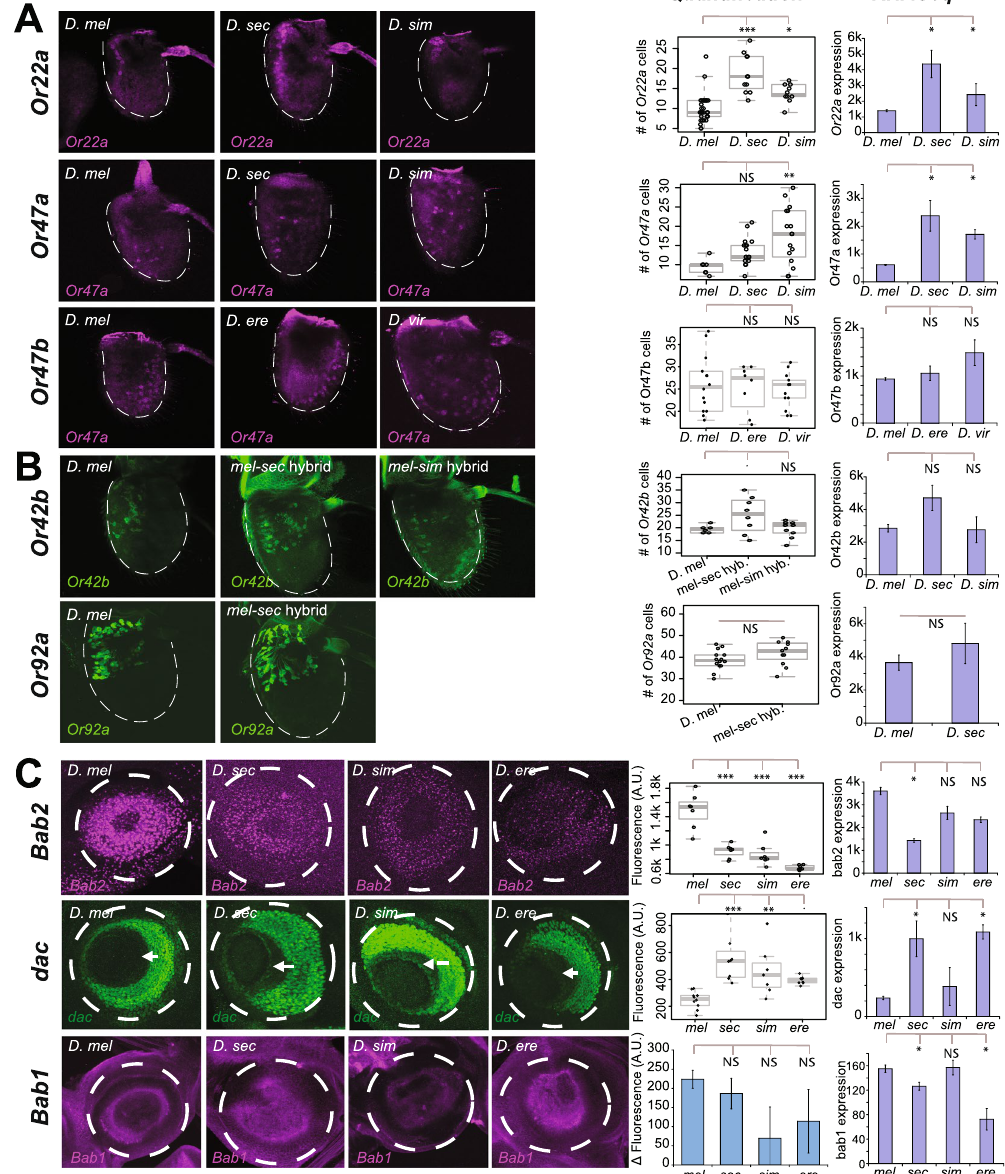
Figure 3. Validation of RNASeq results with in vivo experiments. (A) Fluorescent RNA in situ hybridization for Or22a , Or47a and Or47b genes in the antenna across multiple species. (B) Reporter analysis for D . melanogaster hybrid F1 crosses carrying promoter-fusion GFP constructs for Or42b and Or92a in the antenna. D . mel . – D . sim . hybrid crosses for Or92a did not produce any progeny. (C) Antibody stainings for the Bab2 and Dac proteins, and RNA FISH for bab1 , in the 3 rd instar larval antennal disc across multiple species. White arrows in dac images indicate expansion of dac towards the central fold in some species. Quantification for dac is for an area within the zone of expansion. Quantification for bab1 is for the difference in fluorescence of the antennal disc between antisense and sense probes. Statistical comparisons for in vivo comparisons shown are ANOVA + Tukey’s HSD, which controls for family-wise false discovery rate (p < 0.1, * p < 0.05, ** p < 0.01, *** p < 0.001, NS = not significant), except for Or92a which shows the uncorrected results for a Student’s T-test. RNASeq figures show DESeq-normalized transcript counts, with error bars indicating S.E.M., and significant comparisons shown are for DESeq. 2-calculated adjusted p-value using stringent criteria ( * p < 1E-8). FDR was controlled for using Benjamini-Hochberg method. Also shown is the correlation between predicted RNASeq pairwise log fold change in gene expression and the corresponding log fold change in the quantification of in vivo comparisons (see Fig.